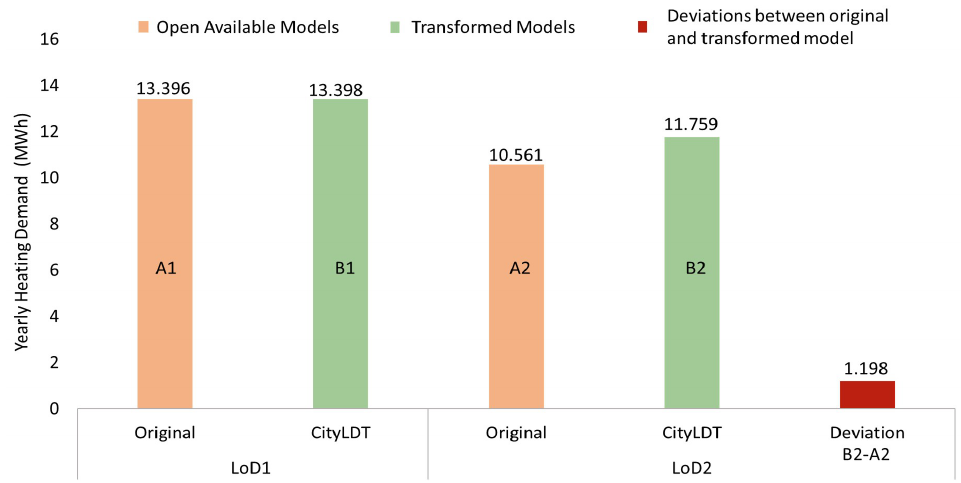
Figure 11. Comparison of heating demand simulation ( MWh ) for open (A1 and A2) and upscaled (B1 and B2) for a period of one year.